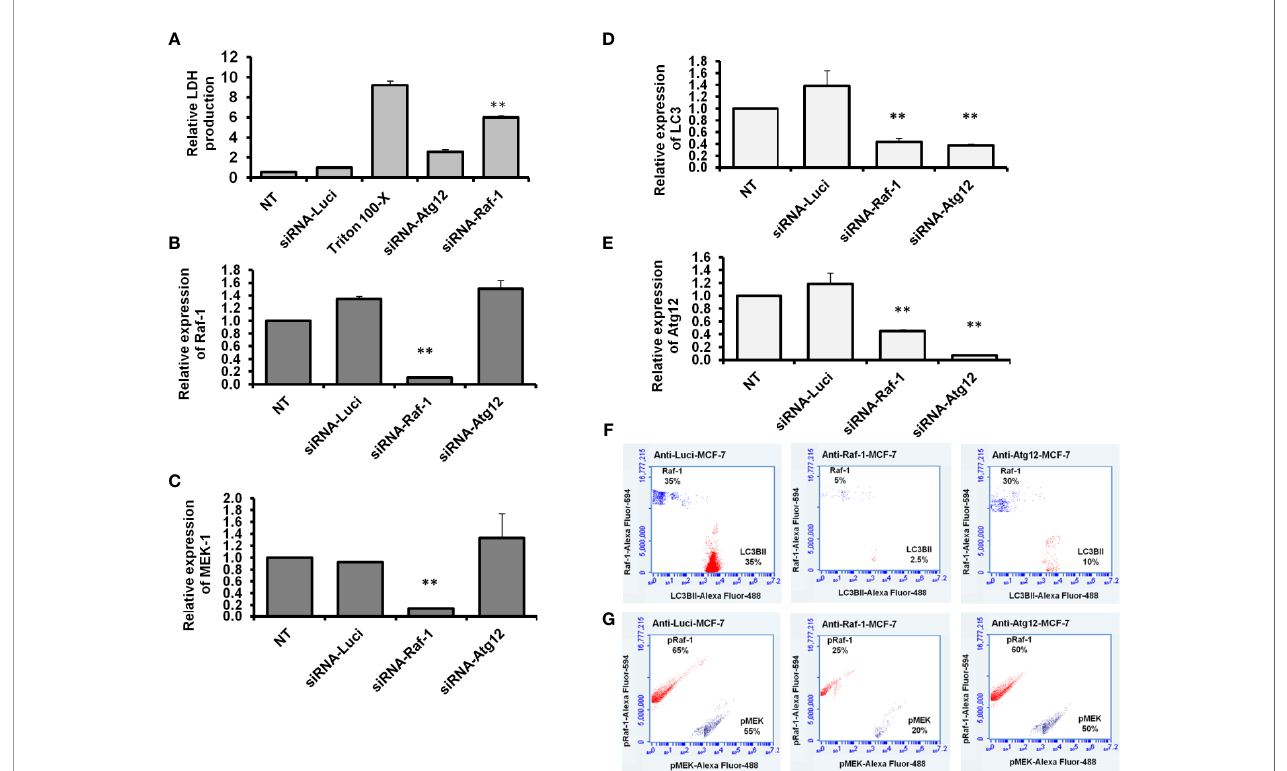
FIGURE 4 | Knockdown ef fi ciency and expression pro fi le of Raf-1, MEK1, LC3B, and ATG12 in siRNA-transfected cells. (A) Relative LDH production from transfected cells upon 2 days posttransfection compared with the control-transfected cells, n = 4. Error bars indicate the SD of four biological replicates (B, C) Relative gene expression of Raf-1 and MEK1, respectively in siRNA-transfected MCF-7 cells upon 48 h posttransfection compared with the control-transfected cells (siRNA anti-Luciferase). (D, E) Relative gene expression of autophagy-related LC3B and Atg12, respectively, indicated by the fold change in siRNA-transfected cells compared with the control-transfected cells. Levels of GAPDH – mRNA were used as an internal control. Error bars indicate the SD of three independent experiments. (F) Quanti fi cation analysis of total Raf-1 and lipidated LC3B in the transfected MCF-7 cells indicated by fl ow cytometry and compared with the control-transfected cells. (G) Quanti fi cation analysis of kinetic protein pro fi le of pRaf-1 and pMEK in transfected MCF-7 cells indicated by fl ow cytometry and compared to control- transfected cells. Data are representative of three independent experiments. A Student ’ s t-test analysis was performed. ** p <